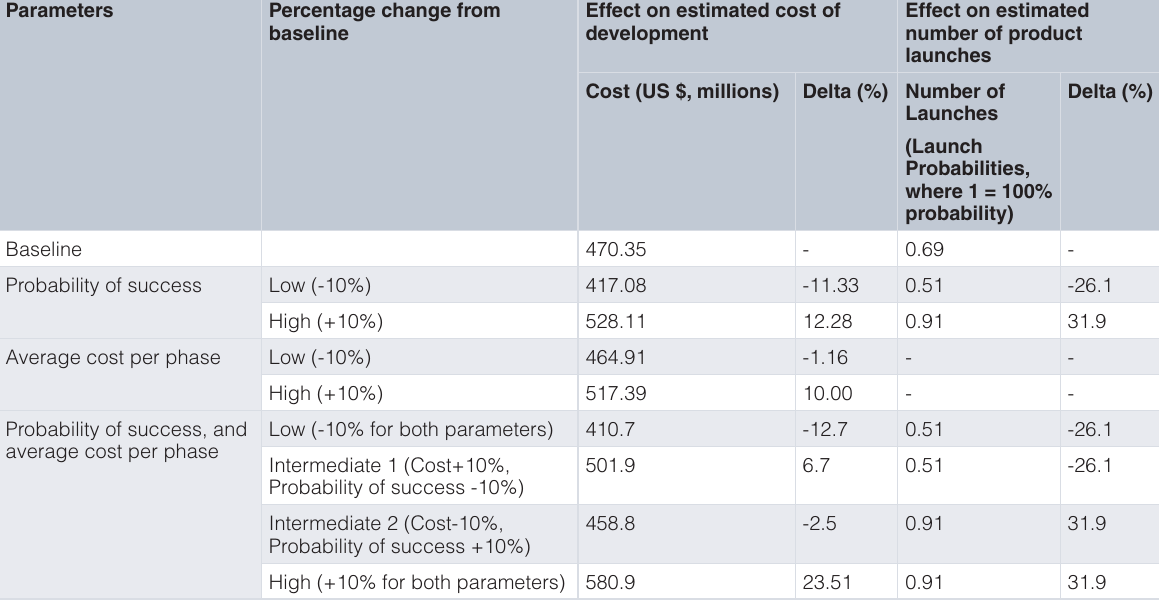
Table 8. Results of the sensitivity analysis for first run of the model.